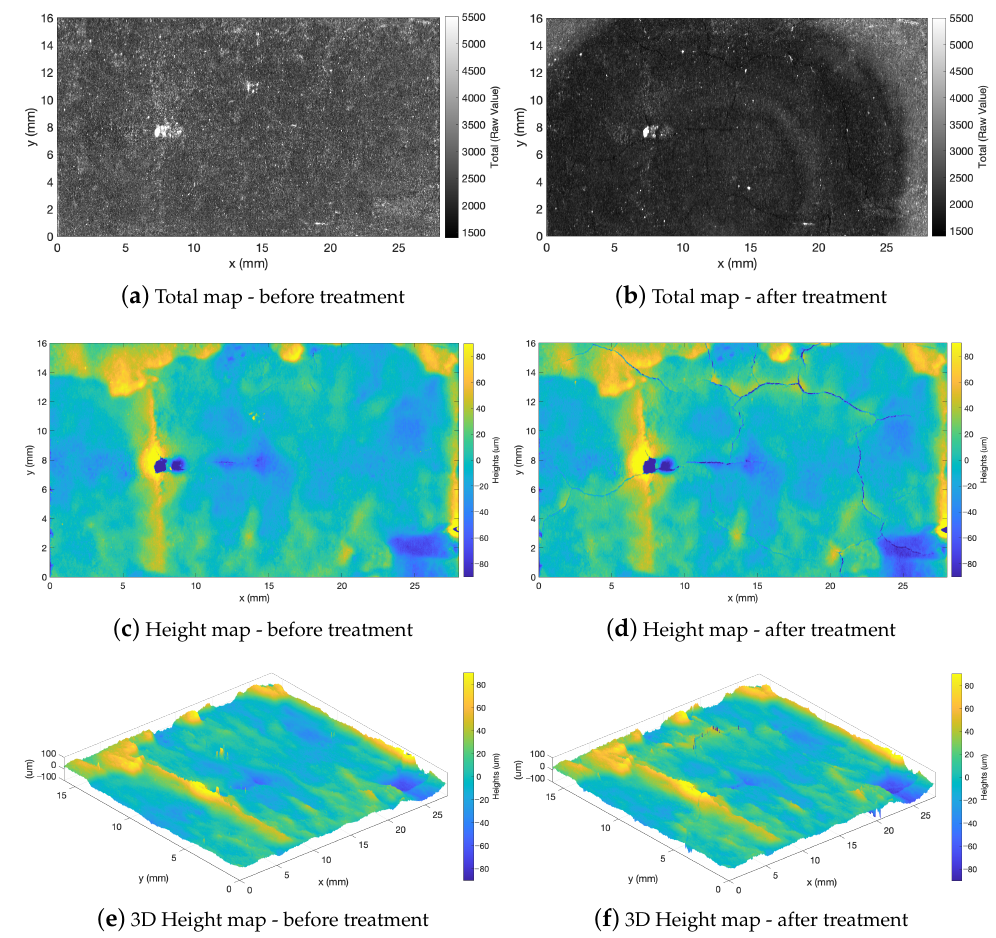
Figure 11. Spatially registered microprofilometry for multi-temporal surface monitoring. The mold was subjected to a treatment in a glasswork and acquired in laboratory in different periods. In-plane registration of pre- and post-treatment surface datasets was obtained by image registration on the intensity Total maps. Profilometer seup: ConoPoint HD, 50 mm lens, 10µm scan step, 5mm/s scan